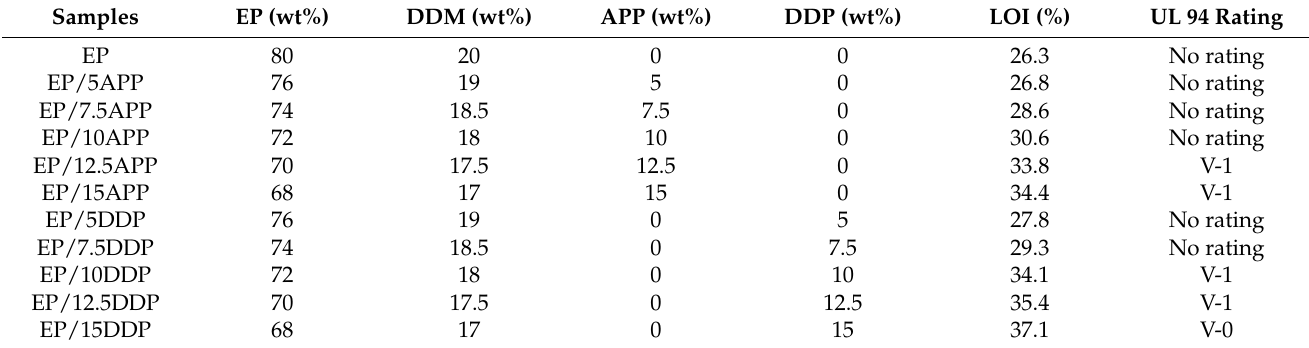
Table 1. Formulation and flammability tests of flame-retardant epoxy resin (mass fraction) %.